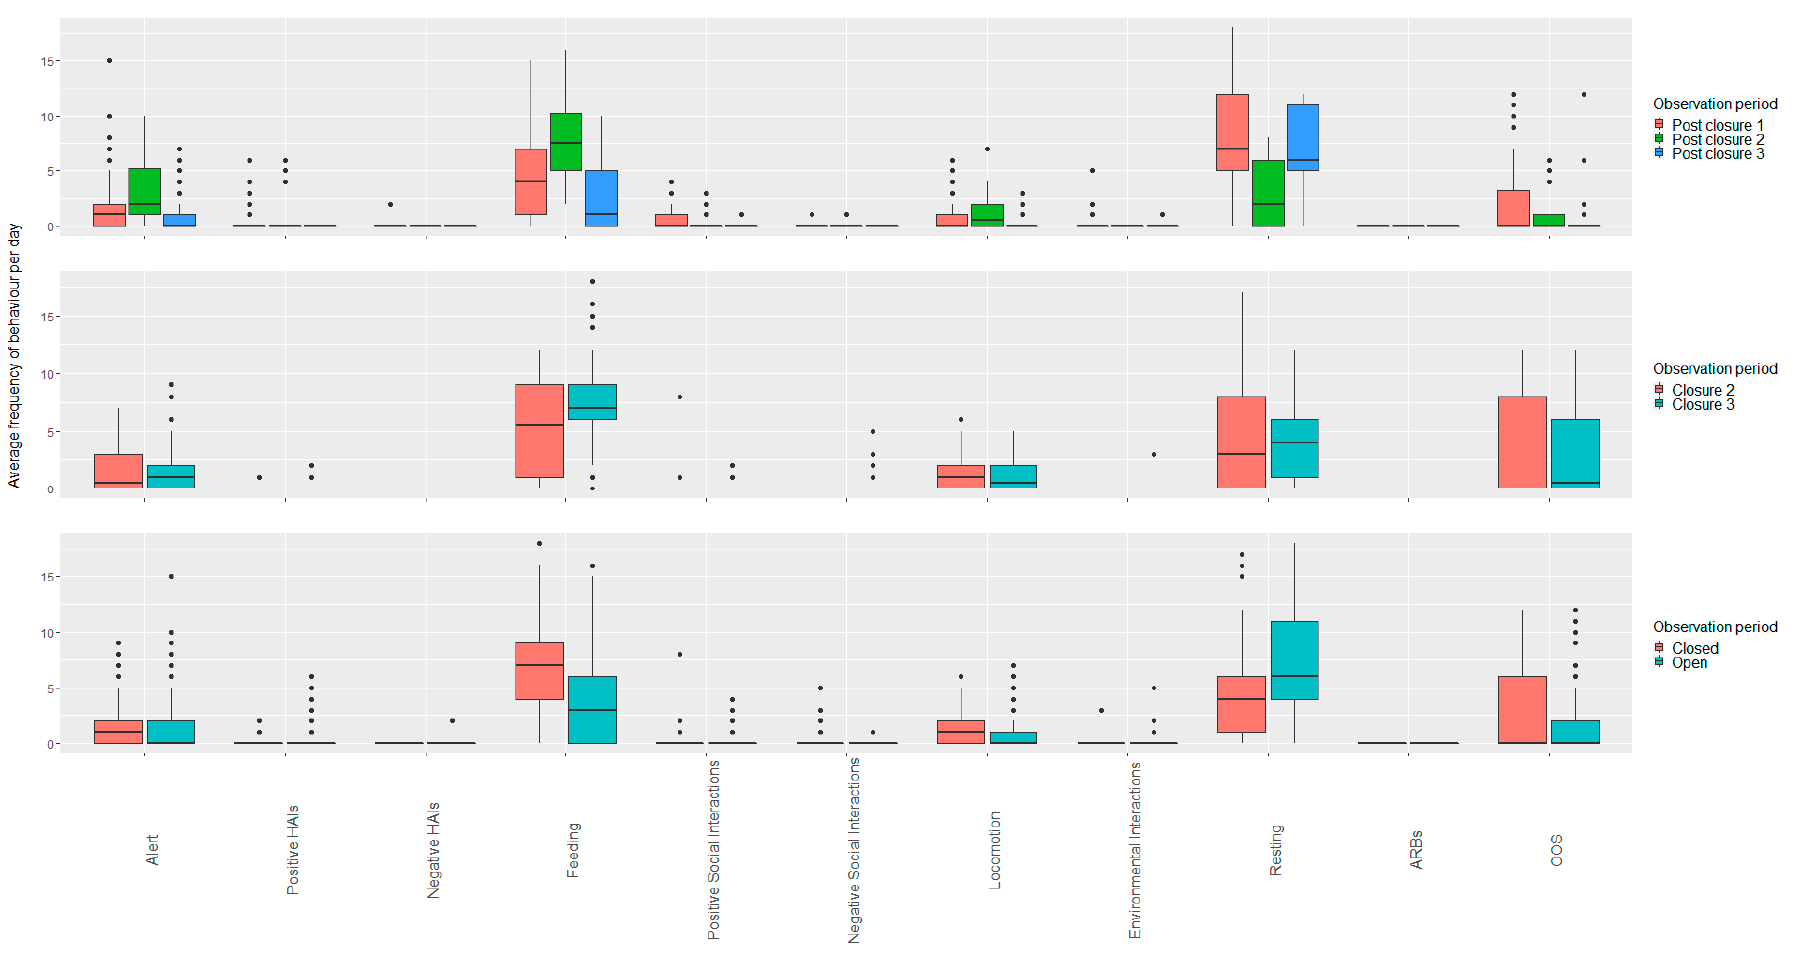
Figure 1. An overview of activity in the Bennet’s wallabies housed at White Post Farm during COVID-19 closures and reopening periods .